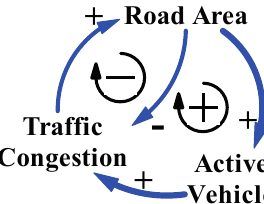
Figure 4. The CLD model reasons the main cause-and-effect variables for city traffic congestion in Taiwan’s